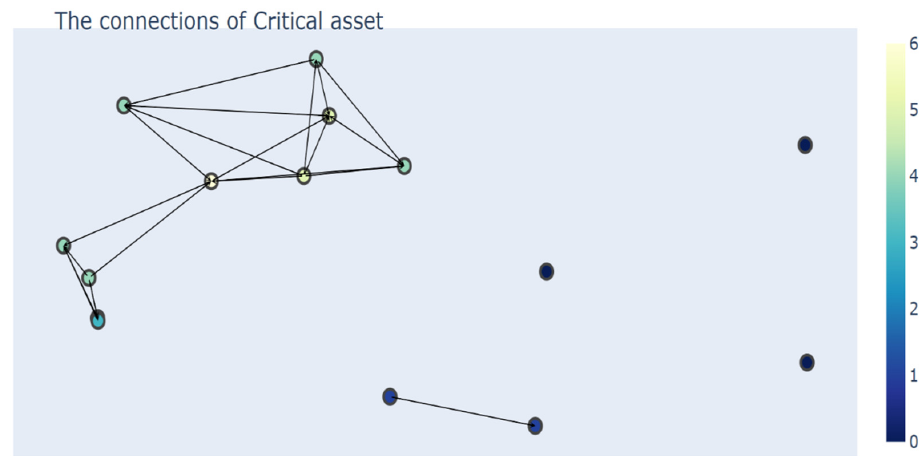
Figure 3. Connections of Critical Assets.